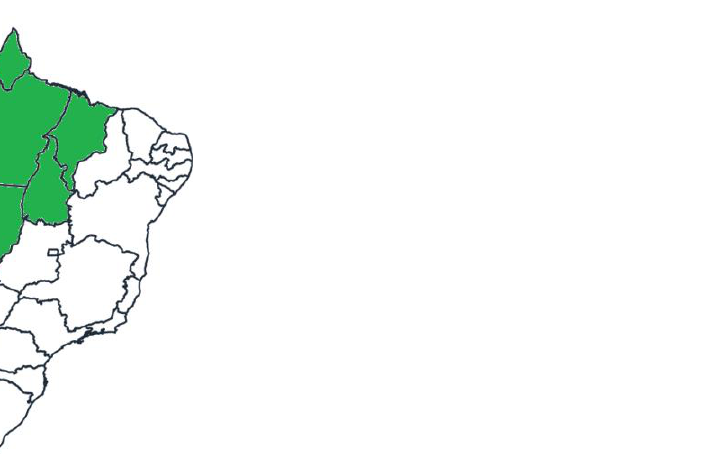
Figure 1. The Eastern Amazon of Brazil, encompassing the states of Amapá (AP), Pará (PA), Mara- nhão (MA), Tocantins (TO) and Mato Grosso (MT). (MA), Tocantins (TO) and Mato Grosso